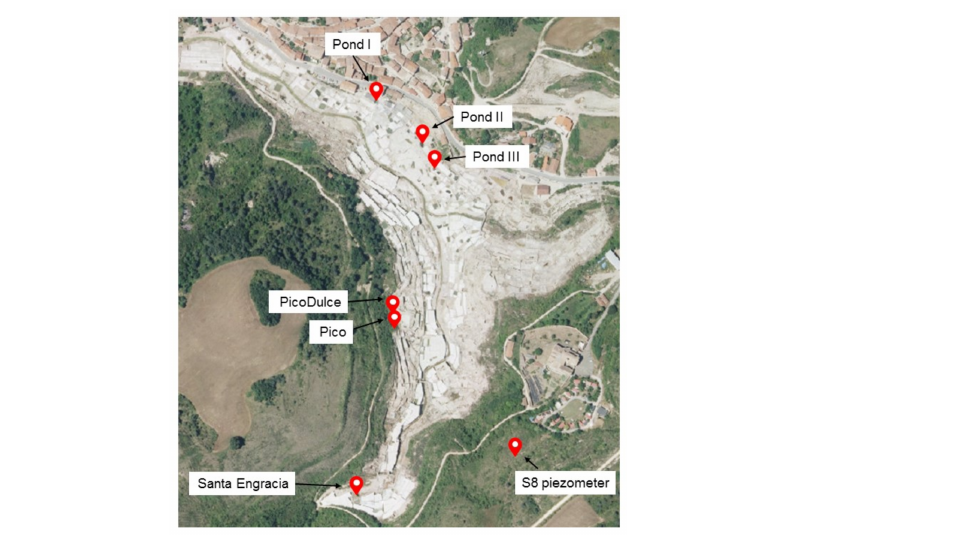
Figure 1. Locations along the Añana Salt Valley studied for fungal diversity and composition determination (photograph obtained from Visor geoEuskadi at https://www.geo.euskadi.eus/s69- bisorea/es/x72aGeoeuskadiWAR/index.jsp, accessed on 26 July 2021). The exact coordinates of each location are as follows: Pond I, 42.8014 N 2.9860 W; Pond II, 42.8009 N 2.9852 W; Pond III, 42.8006 N 2.9851 W; Pico Dulce, 42.7989 N 2.9858 W; Pico, 42.7986 N 2.9856 W; Santa Engracia, 42.7965 N 2.9863 W; S8 piezometer, 42.7970 N 2.9838